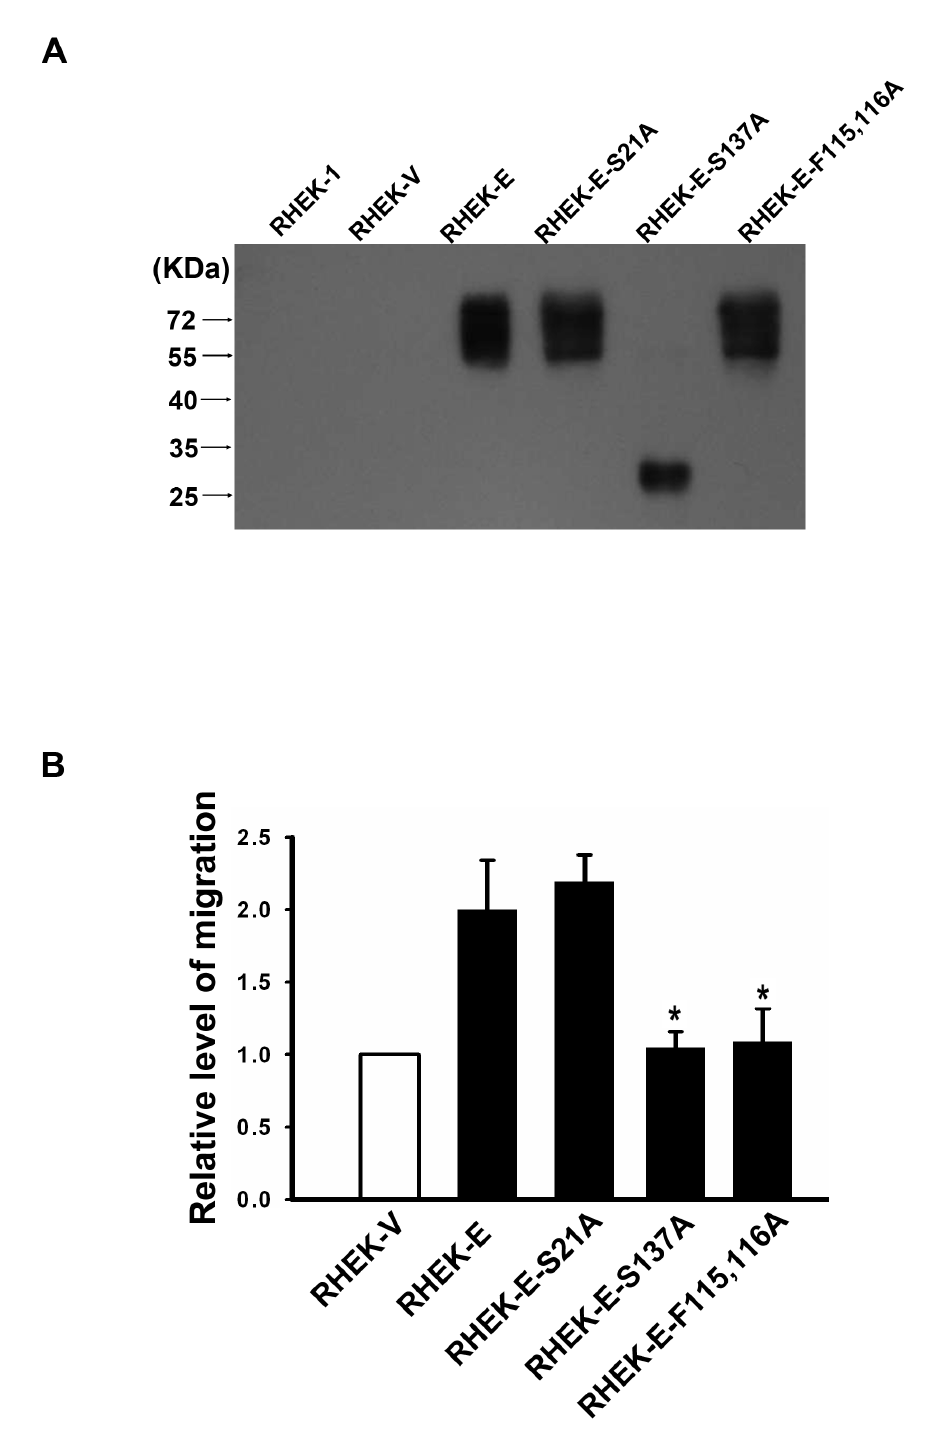
Figure 7. Glycan moiety and phenylalanine-rich region is required for endocan induction of endothelial cell migration. ( A ) Western blot analysis shows the expression of endocan in the concentrated CM of various RHEK-1-derived cell clones. ( B ) The chemotactic activity of CM from various RHEK-1-derived cell clones. The migrated HMEC-1 cells were counted in six randomly selected microscopic fields. Values represent means ± SD. * P < 0.05 versus CM from RHEK-endocan cells. RHEK-V, RHEK-Vec cells; RHEK-E, RHEK-endocan cells. doi: 10.1371/journal.pone.0082254.g007 PLOS ONE |